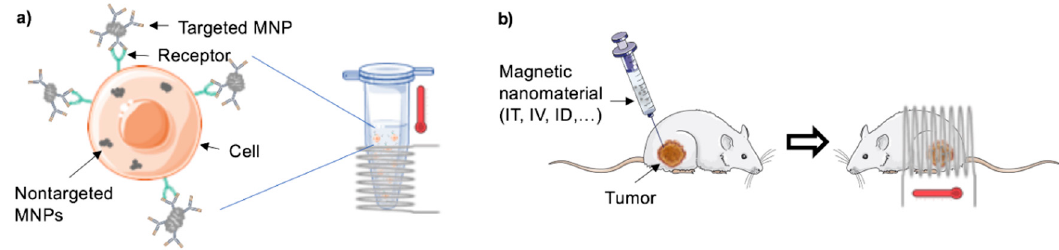
Figure 1. General schematic representation of a magnetic-hyperthermia study ( a ) in vitro and ( b ) in vivo. MNP—magnetic nanoparticle, administration routes: IT—intra-tumoral, IV—intravenous, ID—intradermal .